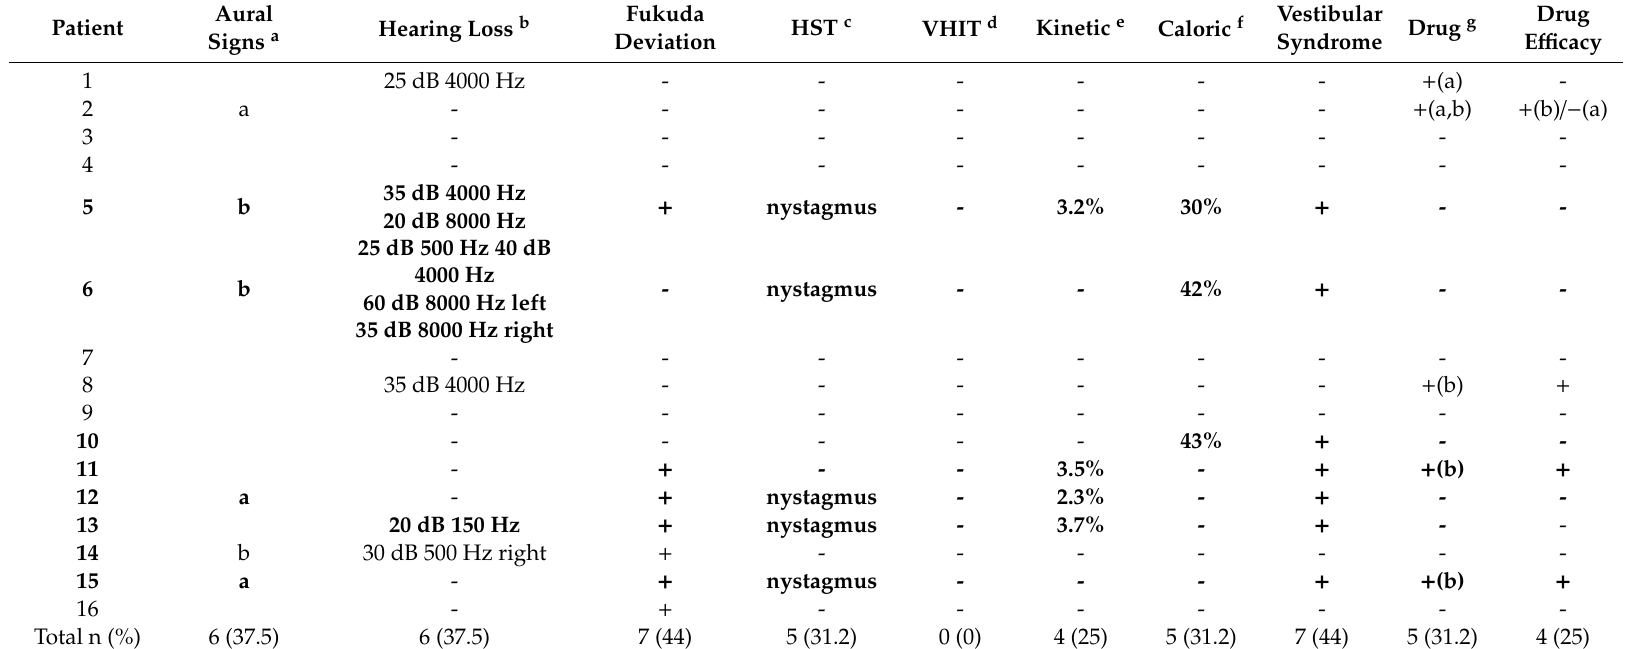
Table 2. Neuro-otological clinical exams and paraclinical test results for Gitelman syndrome patients with